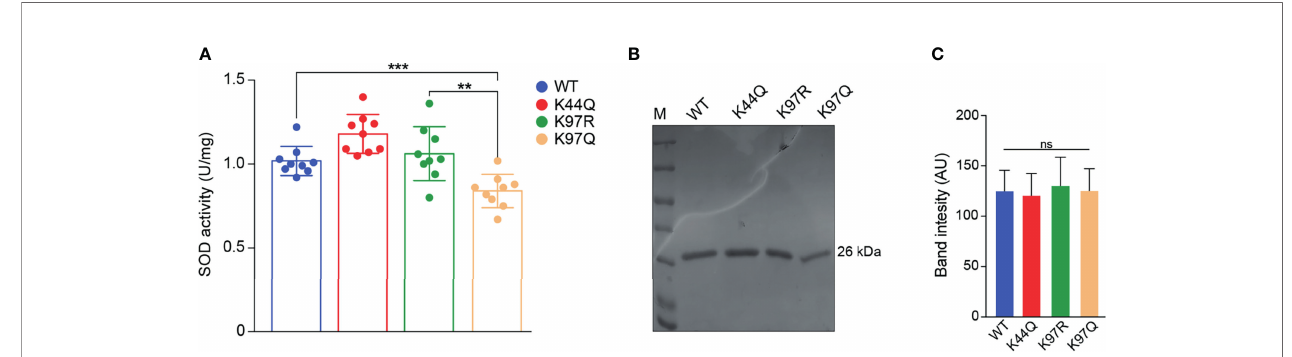
FIGURE 6 | Superoxide dismutase activity of native and mutated versions of TcSODA. (A) Puri fi ed heterologous proteins of TcSODA (native and mutated versions) were submitted to superoxide dismutase assays using NBT oxidation method. A reduction of ~25% was observed for K97Q protein, which mimics acetylation, compared with the native (WT) or K97R versions. No signi fi cant difference was detected for K44Q compared with WT or K97R. All analyses were performed in triplicate. Statistical analyses were performed using the Student ’ s t -test. ** p = 0.0028; *** p = 0.0009. (B) Coomassie gel of TcSODA recombinant proteins was used in the in vitro activity assays. (C) Quanti fi cation of triplicate Coomassie gel of recombinant proteins used in the TcSODA activity assays. No signi fi cant differences were observed among the samples. ns, not signi fi cant.